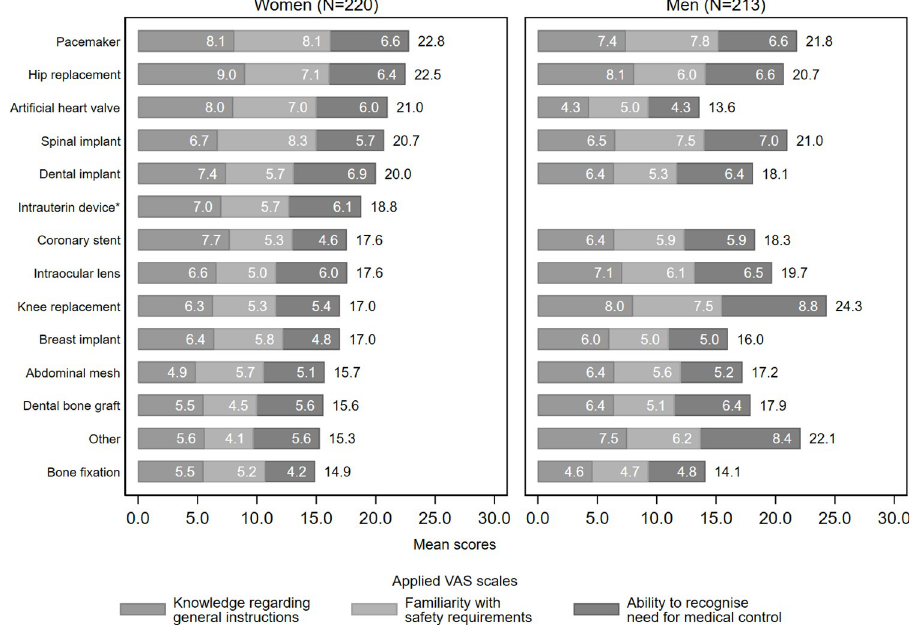
Fig 3. Patients’ knowledge regarding living with implantable medical devices by IMD type as measured on visual analogue scales (0 –‘not at all’; 10 –‘completely’). * Only for women; Numbers outside of columns represent the sum of the corresponding VAS scales. Results for ‘Ability to recognise need for information security or privacy control’ are not shown as it was reported only by patients wearing electronic devices. Data for ‘glucose sensor’ are not presented as only one women case was